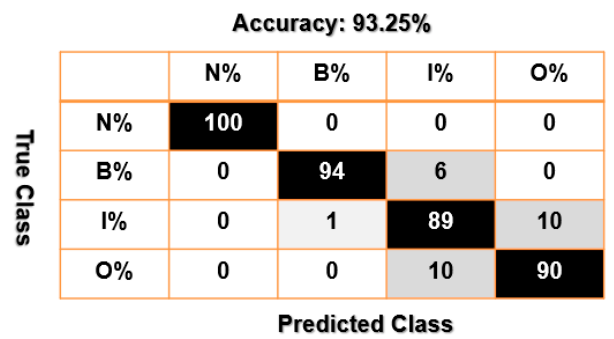
Figure 13. Bearing’s data classification using the combination of FVS and SVM.